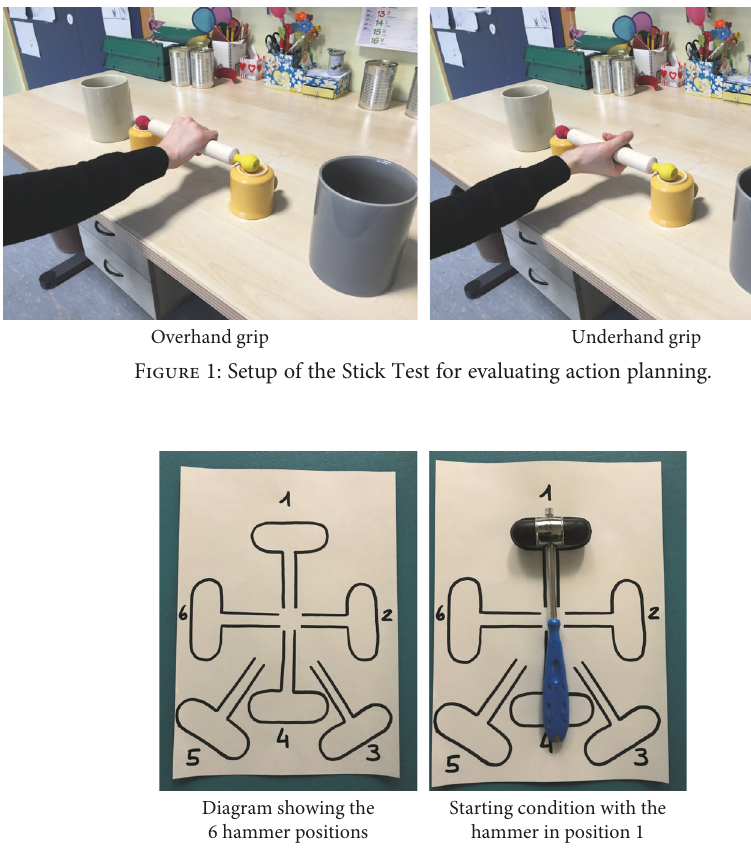
Figure 2: Setup of the Hammer Test for evaluating action planning.